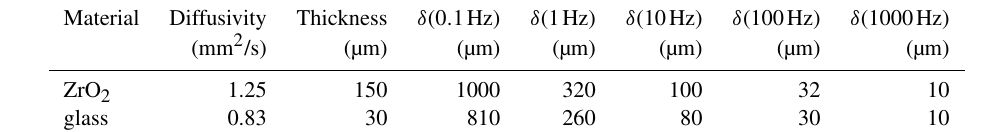
Table 2. Material characteristics at 25 ◦ C: thermal diffusivity (Care, 2009), layer thickness, and penetration depth for frequencies 0 . 1, 1, 10, 100, and 1000Hz.